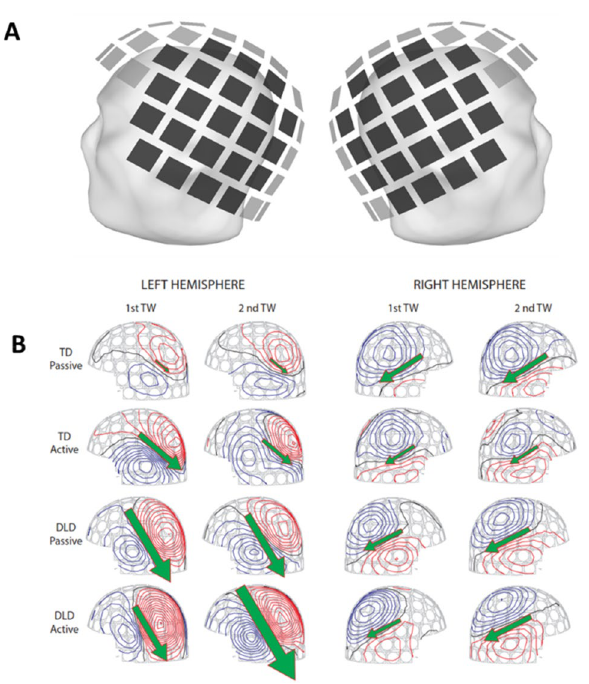
Figure 3. ( A ) Plot representing the 22 sensors included in the ECD model for each hemisphere. ( B ) Field distribution and ECD orientation (arrows) in the left and right hemispheres in both time windows of one subject in the TD group (above) and one subject in the DLD group (below) in active and passive conditions for speech